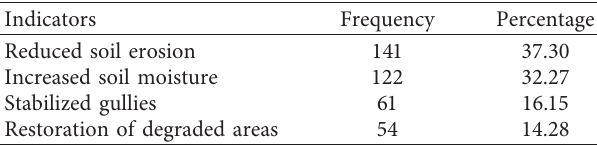
Table 3: Indicators of the impacts of